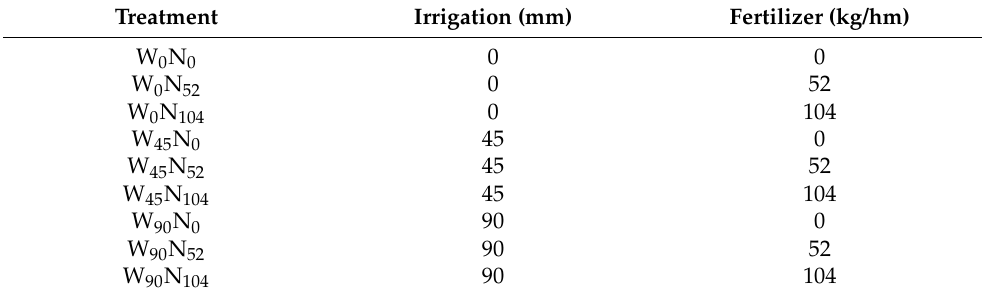
Table 2. Experimental